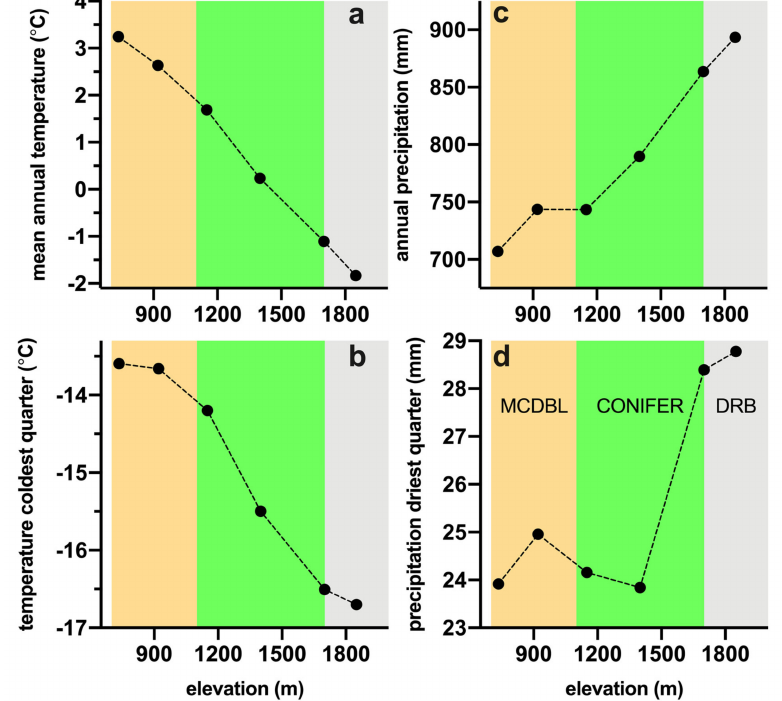
Figure 2. Trends in climatic variables of sampling sites along elevation: ( a ) mean annual temperature ( ◦ C), ( b ) temperature of the coldest quarter ( ◦ C), ( c ) annual precipitation (mm), and ( d ) precipitation of the driest quarter (mm). Also shown are the approximate elevational bands of the three main forest types sampled: MCDBL = mixed conifer-deciduous broadleaf (peach); CONIFER = conifer (green); DRB = dwarf rock birch